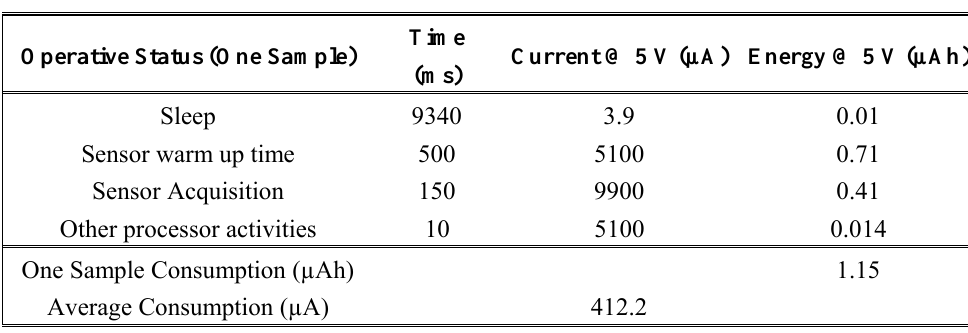
Table 1. Detailed UISI electrical power